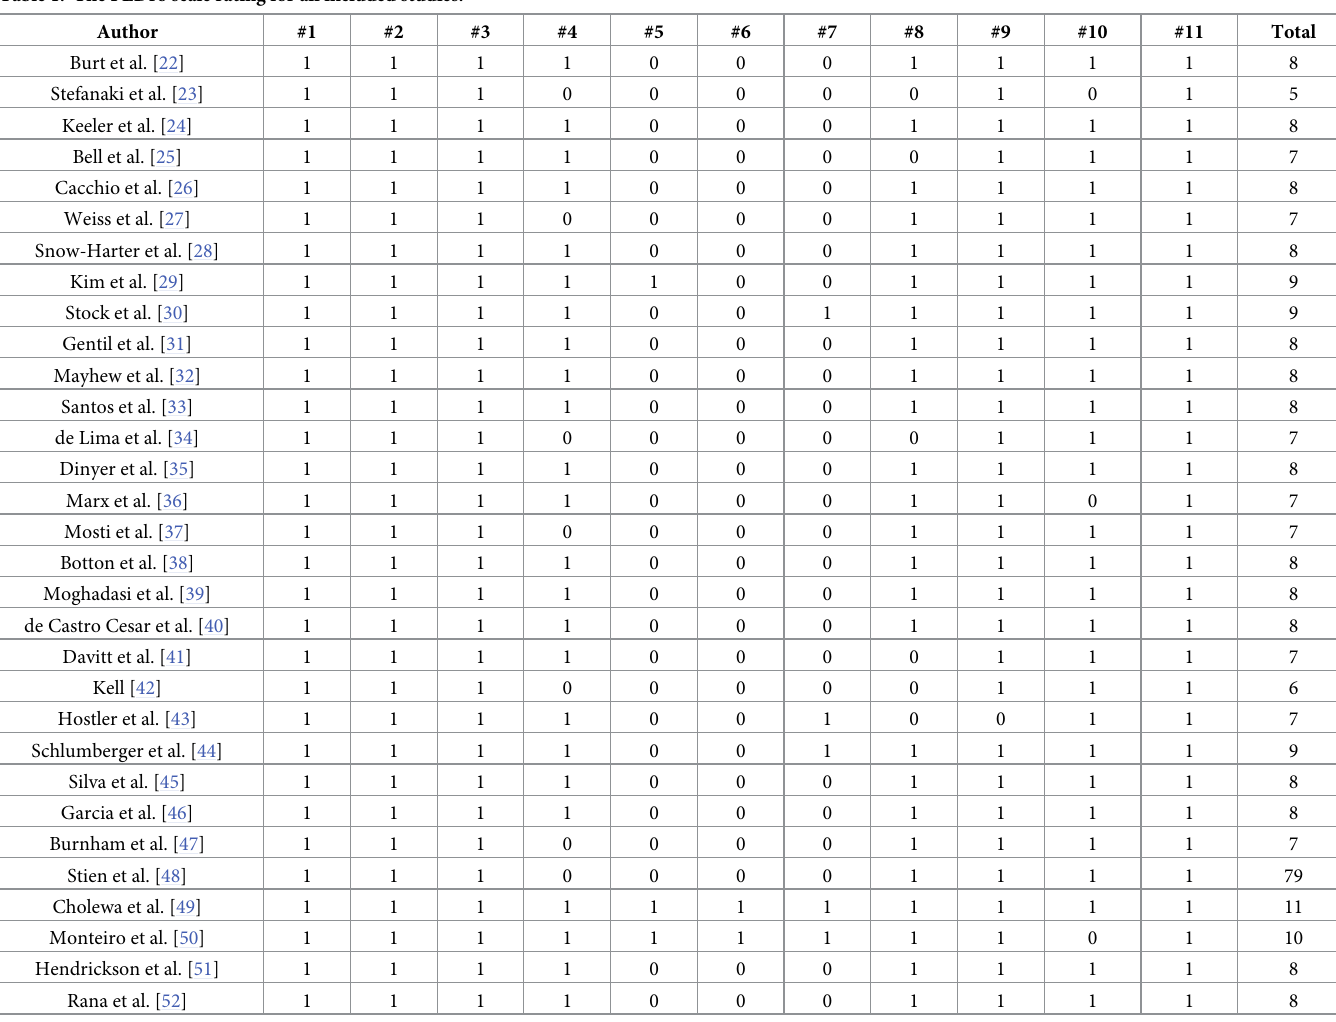
Table 1. The PEDro scale rating for all included